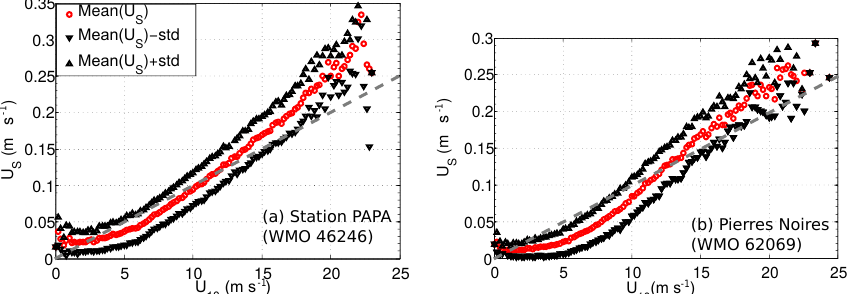
Figure 4. Example of mean value (in red) of the Stokes drift vector norm U S =| (U S , V S ) | as a function of wind speed for two locations: station PAPA in the northeast Pacific, and buoy 62069 off the French Atlantic coast. The black symbols show the mean ± 1 standard deviation for each wind speed. The dashed grey line is U S = 0.01 U 10 . This estimation covers only frequencies up to